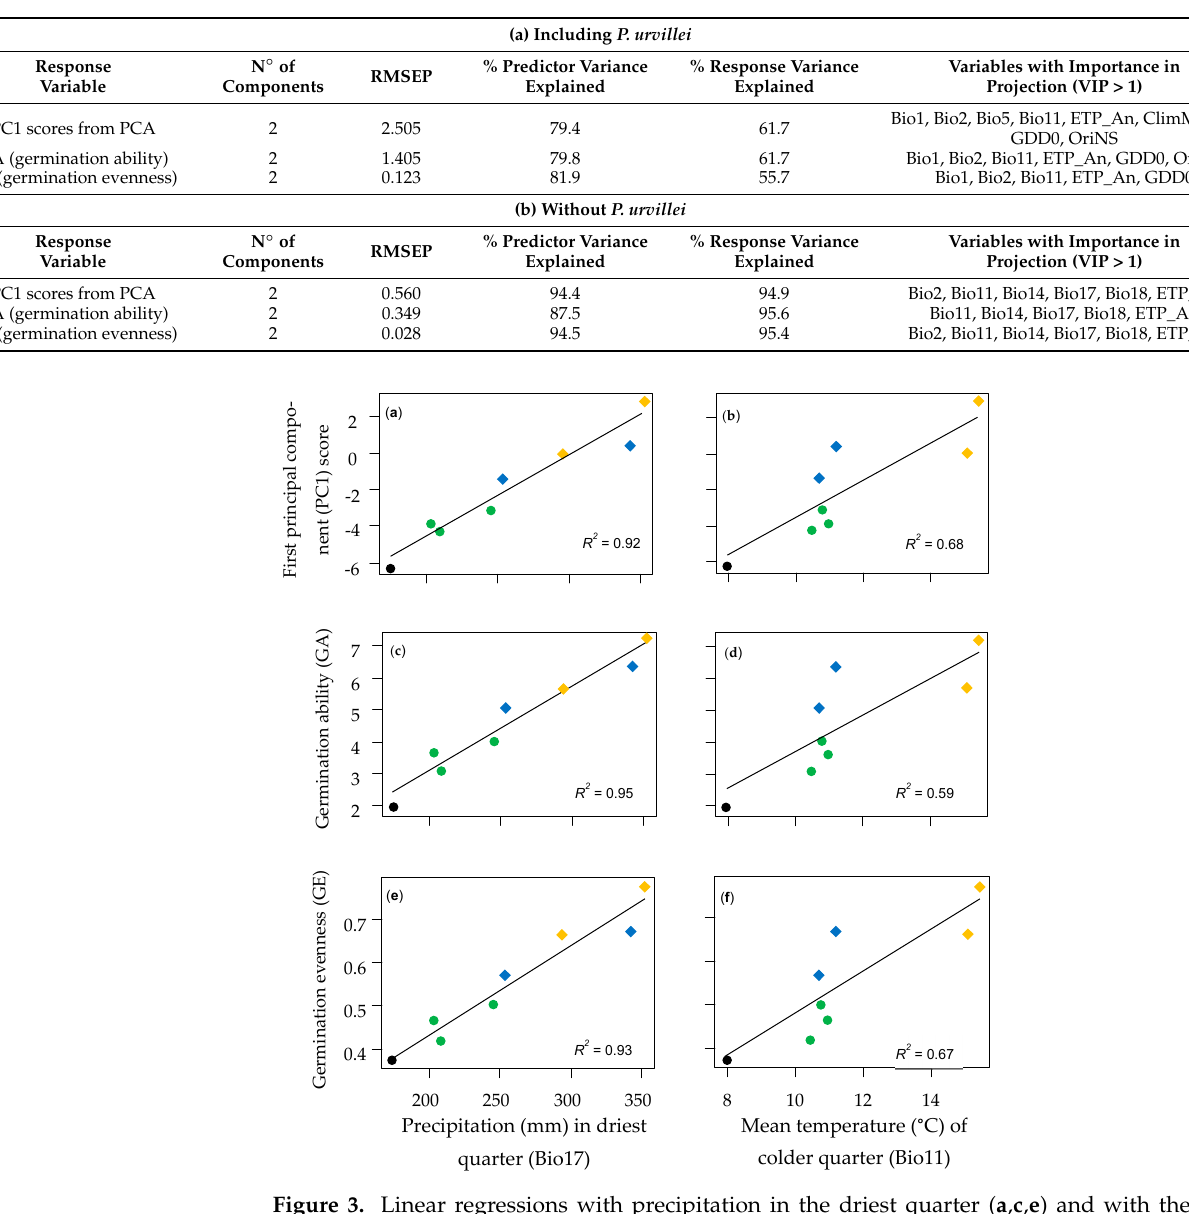
Table 3. Optimization results of partial least square regressions (PLSR) were performed for each response (germination) variable. ( a ) Optimization including P. urvillei genotypes. ( b ) Optimization without P. urvillei genotypes. Root mean squared error on prediction (RMSEP) for the selected number of components and percentage of predictor (environmental variables) and response (germination variables) explained by PLSRs are shown. The predictor variables with importance in projection higher than one (VIP > 1) were listed for each PLSR optimization. Abbreviations and sources of each predictor variable are noted in Table A1.